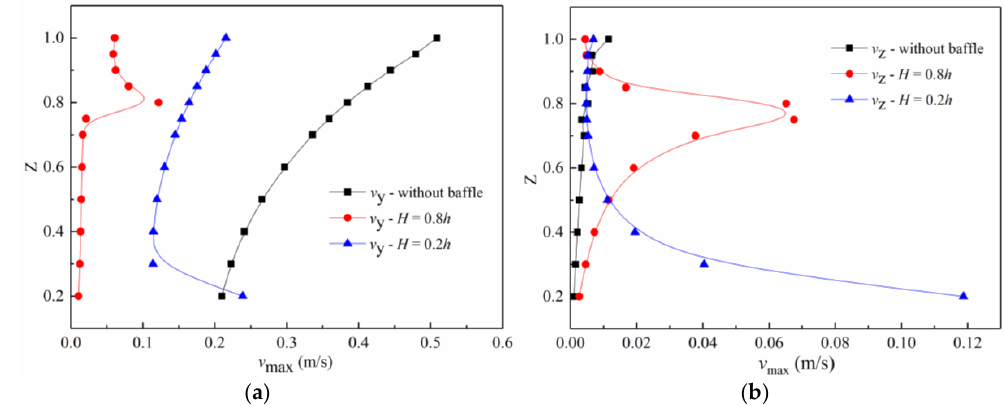
Figure 12. The vertical distribution of the maximum flow velocity at the tank center under different baffle heights. ( a ) Horizontal component of velocity; ( b ) Vertical component of velocity.